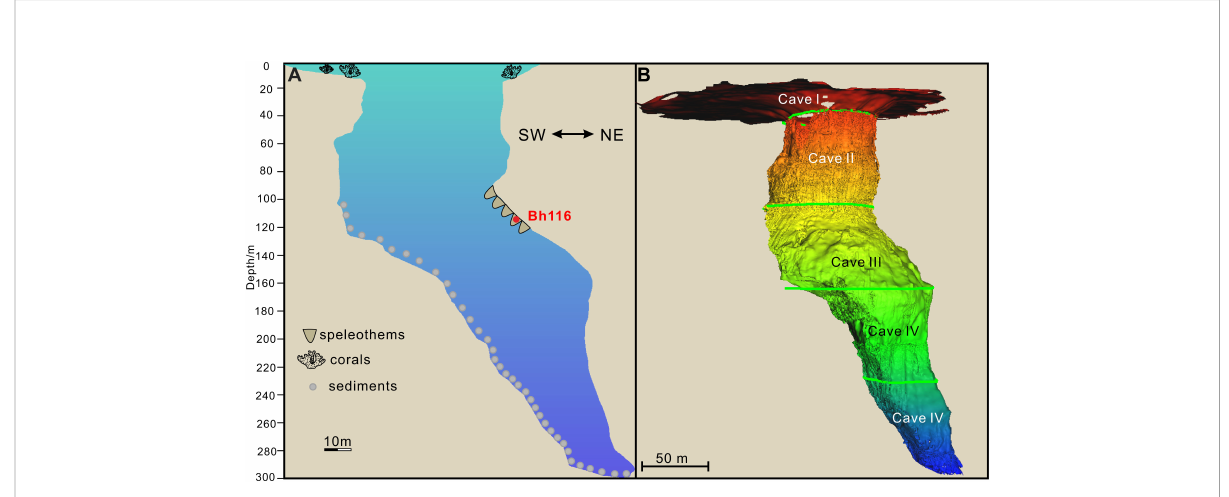
FIGURE 2 Cross-section (A) and 3-D topography (B) of Sansha Yongle Blue